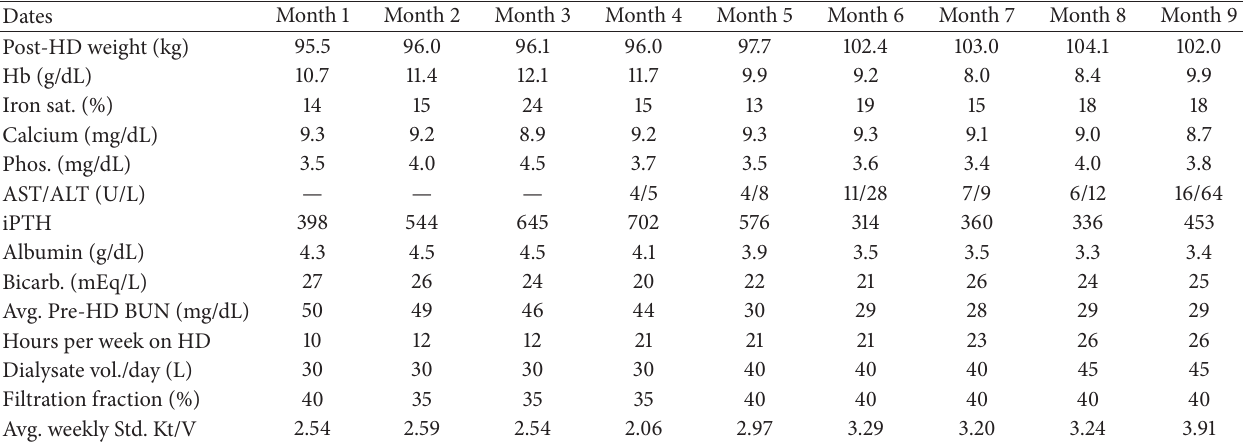
Table 2: Laboratory